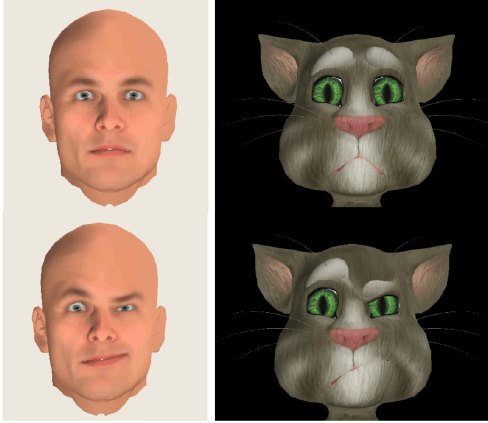
Figure 21. Application of proportions in a cat